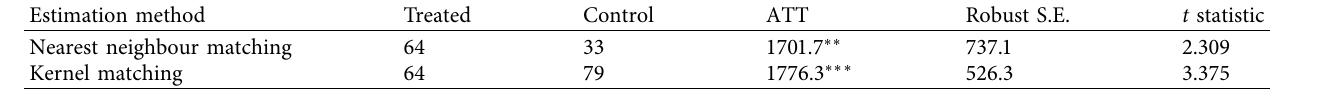
Table 5: Estimates of the average treatment effect of off-farm work on farm